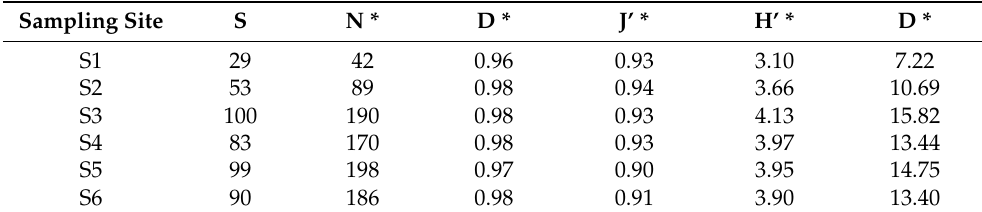
Table 1. Traditional biodiversity indices of the six sampling sites. S: number of species (including macrophytes); N: number of specimens; D: Simpson index; J’: Pielou index; H’: Shannon index; d: Margalef index. Indices marked with * are calculated for macrofauna only.